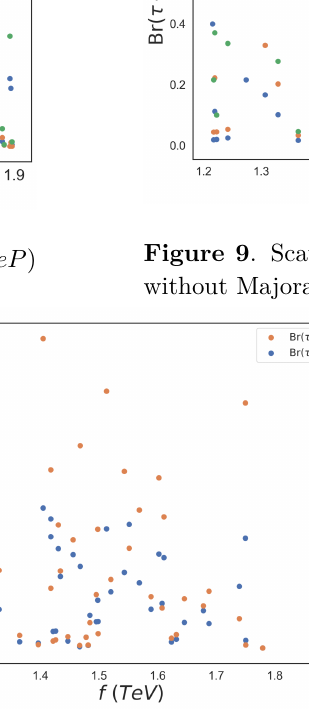
Figure 10 . Scatter plot f vs. Br( τ → eV ) without Majorana neutrinos